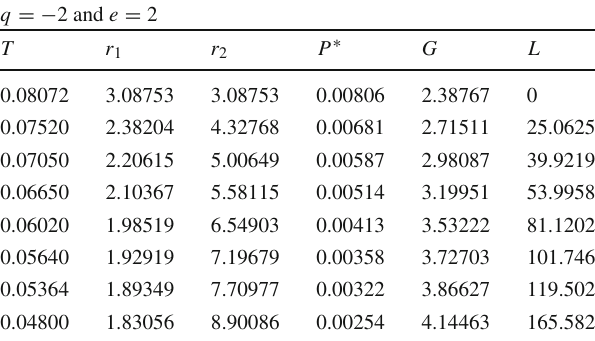
Table2 Thenumerical resultsoftheMaxwell equalarealawEqs. (3.3) and(3.21), theGibbsfreeenergyEq.(3.15), andthelatentheatEq.(3.4) for the spherically symmetric AdS hairy black hole with the Maxwell